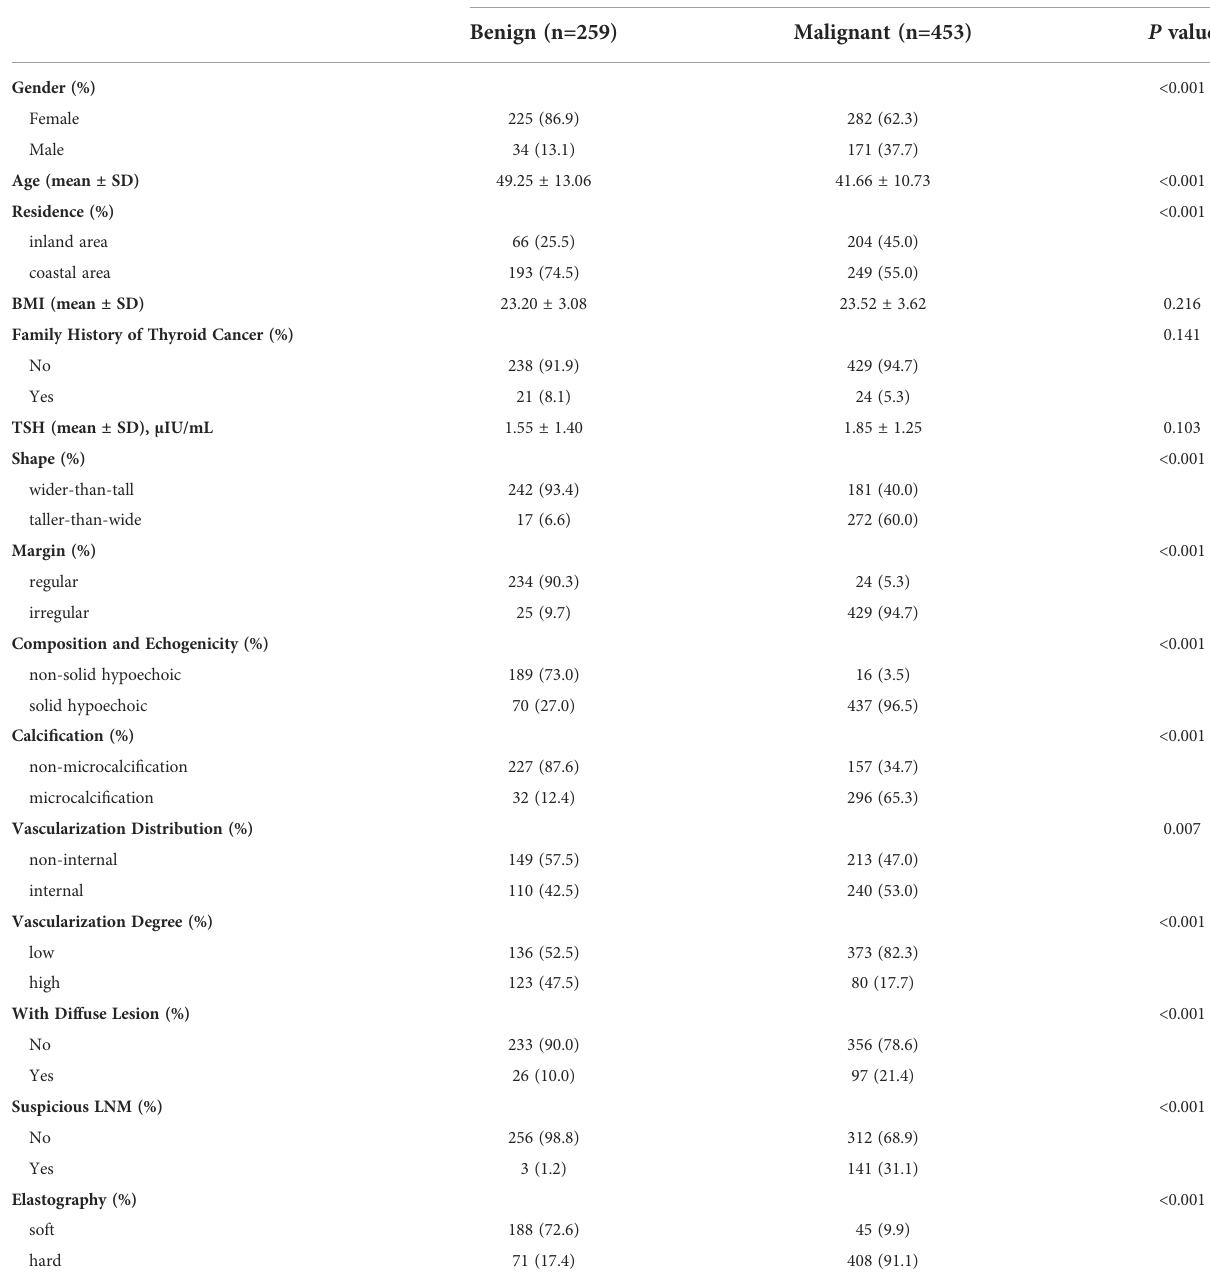
TABLE 1 Univariate analysis of risk factors for thyroid cancer in the training